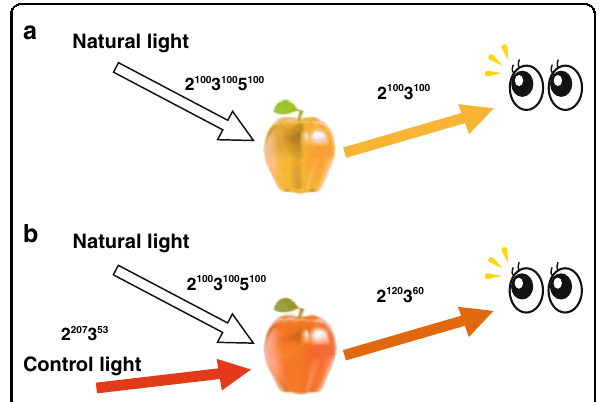
Fig. 5 The design of a smart lighting system. a An apple observed under natural light. b An apple observed under a control